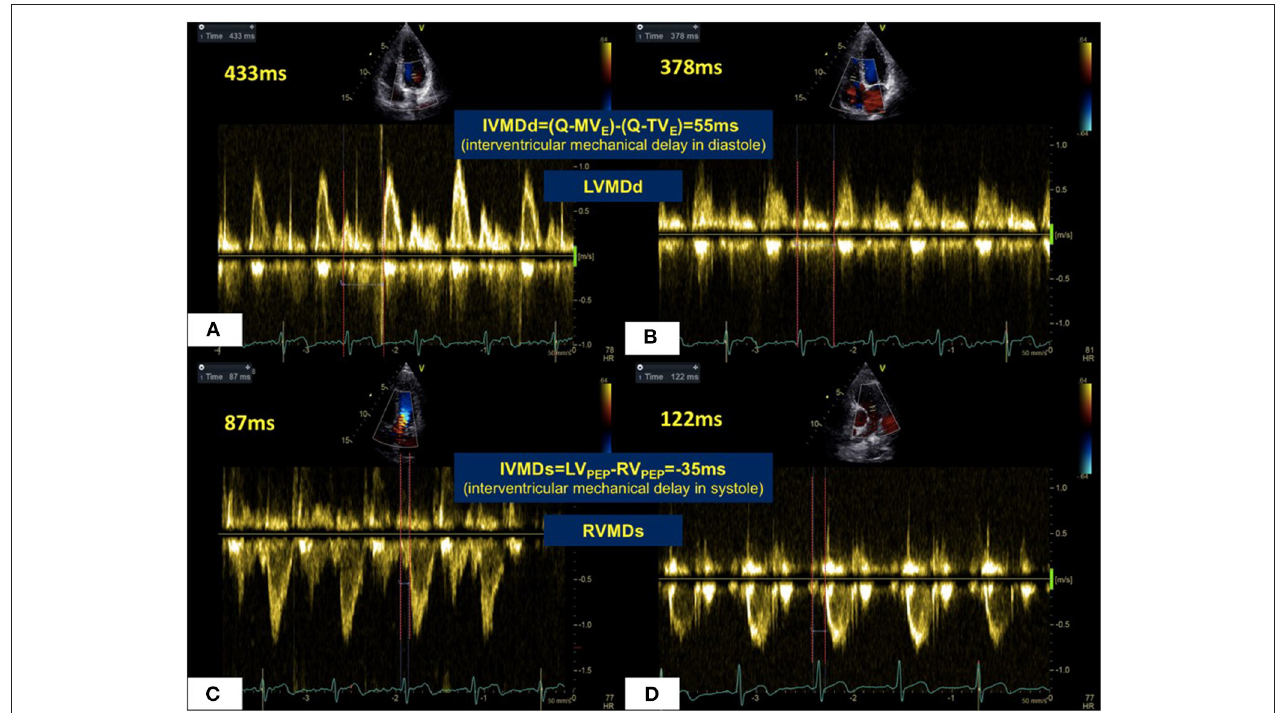
FIGURE 2 | Mechanical sequences in the LV and RV in a normal healthy subject. In diastole (A,B) , RV filling occurred 55ms prior to LV filling giving a LVMDd pattern. For systolic ejection (C,D) , LV ejection preceded RV ejection by 35ms in RVMDs pattern. Abbreviations as in legend to Figure 1 .